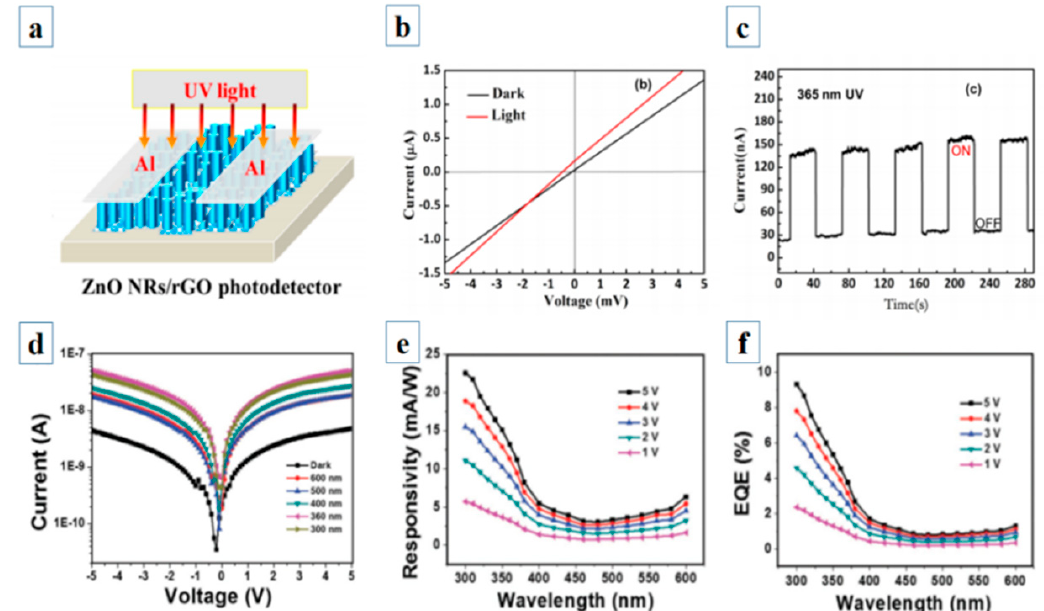
Figure 12. ( a ) Structural schematic of ZnO NRs/rGO photodetector; ( b ) I – V curves of ZnO/rGO photodetectors both in the dark and 365 nm UV illumination by sweeping the bias voltage from − 5 to 5 mV at a 1 mV scanning rate; ( c ) time-dependent photocurrent curve of the ZnO/rGO nanohybrid photodetectors at 0 V bias; ( d ) I – V curves of the ZnO/graphene nanodot array (GNDA; 20 nm) photodetector (PD) in the dark and under light illumination at various wavelengths; ( e ) responsivity spectra of ZnO/GNDA (20 nm) PD under various bias voltages; ( f ) EQE spectra of ZnO/GNDA (20 nm) PD under various bias voltages.